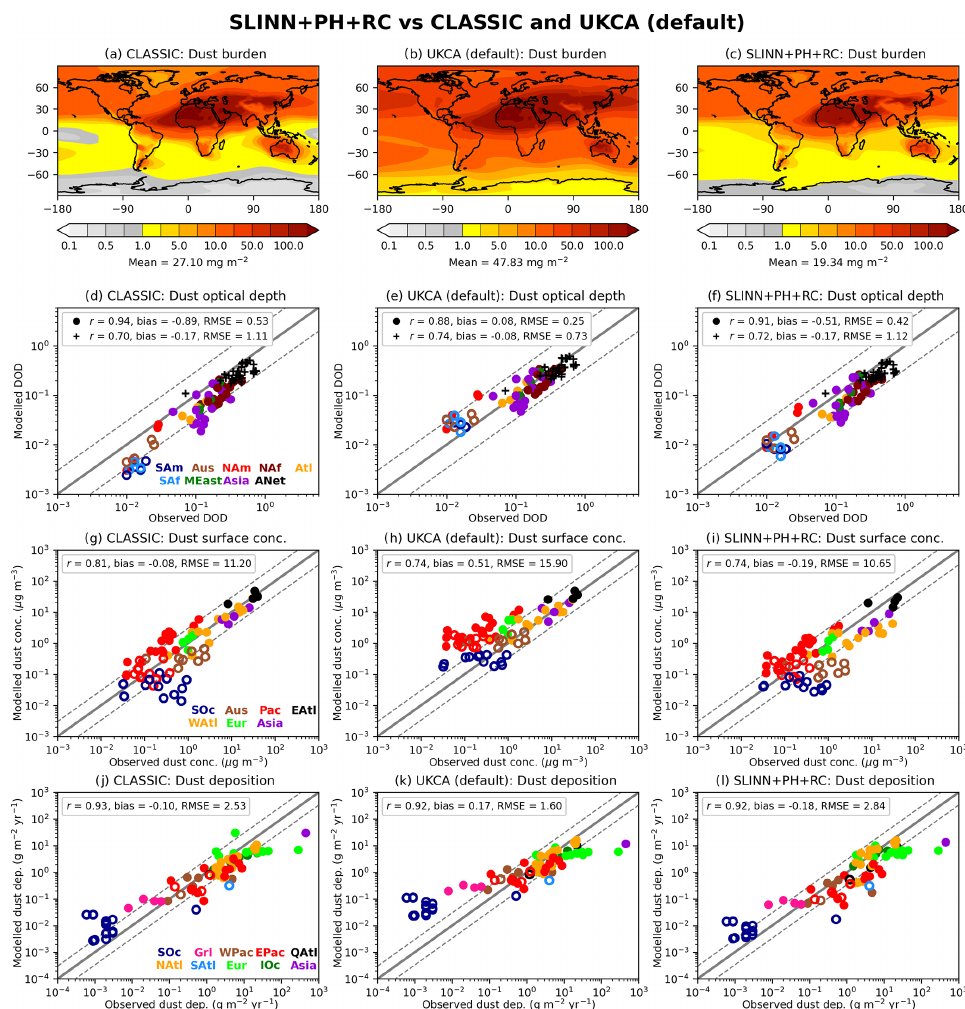
Figure 11. The same as Fig. 7 but used to compare the SLINN + PH + RC simulation with UM-GA8.0 with CLASSIC dust (left column) and UM-GA8.0 with UKCA-mode dust and its default BCS scheme. This is used to answer the supplementary question, the impact of the Slinn + ph + rc BCS scheme versus existing UM-GA8.0